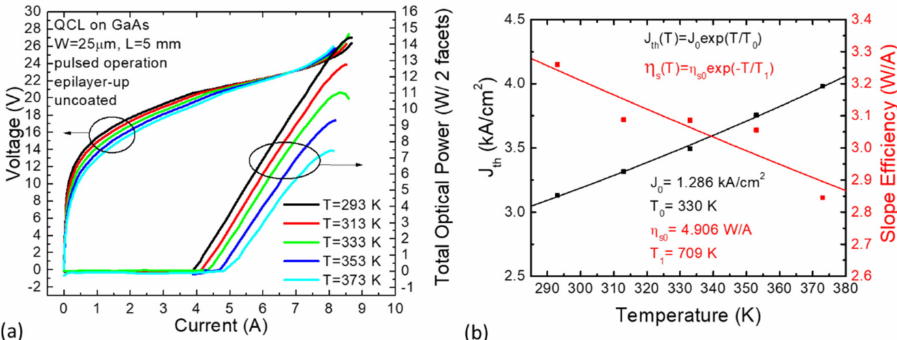
Figure 4. ( a ) Temperature-dependent characteristics of QCL on GaAs. ( b ) Plot of extracted J th and η s data as a function of temperature. Solid lines represent exponential fits to the